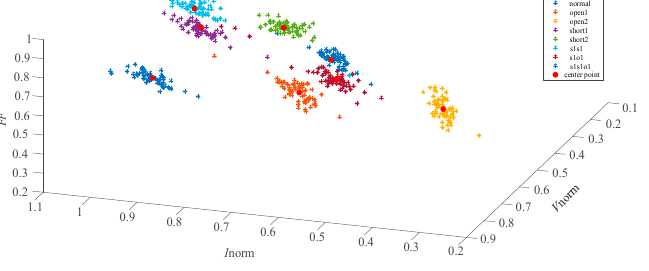
Figure 10. The distribution of eight fault characteristic points ( V norm , I norm , FF ) and clustering center points in the field experiment.